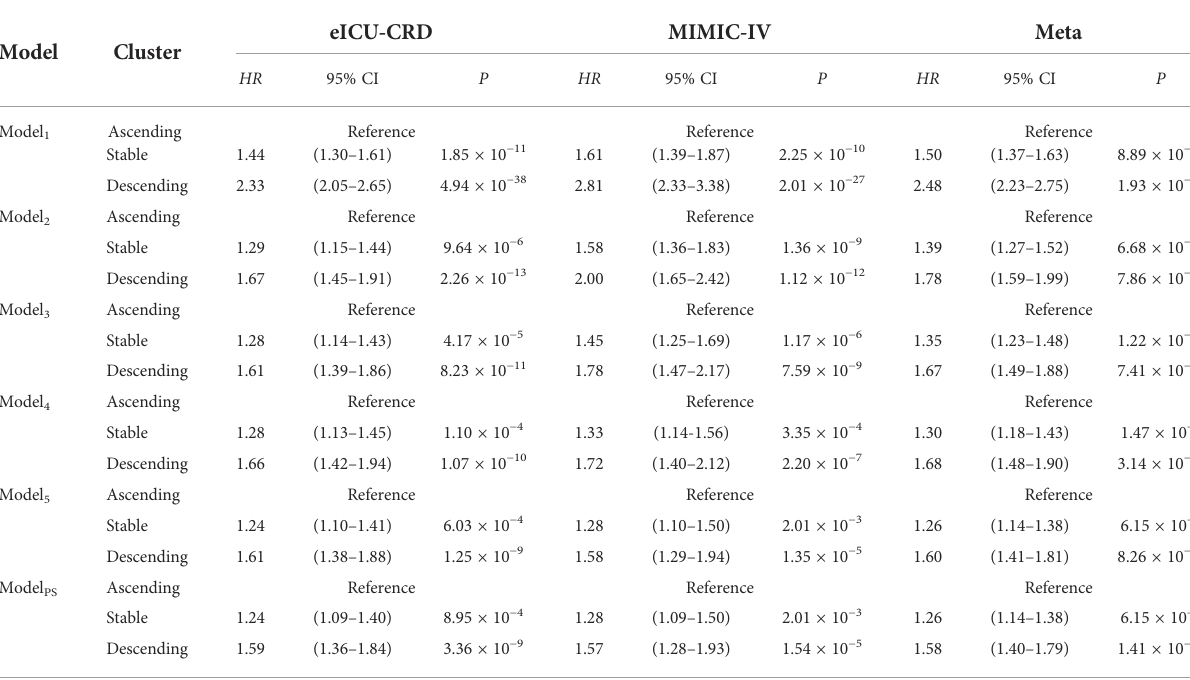
Model 1 : adjusted for age, gender, ethnicity, baseline platelet count, antiplatelet treatment, platelet transfusion, transfusion amount, malignancies, hematologic diseases, immune therapy, thrombotic diseases, and thromboin fl ammatory diseases. Model 2 : additionally adjusted for fi rst ICU location, ARDS, sepsis, SOFA, APS-III, and supports within 24 h (mechanical ventilation, vasopressor, and dialysis) upon model 1 . Model 3 : additionally adjusted for differential vital signs upon model 2 . Model 4 : additionally adjusted for differential laboratory results upon model 3 . Model 5 : additionally adjusted for differential comorbidities upon model 4 . Model PS : adjusted for all aforementioned covariates using the propensity score (PS)